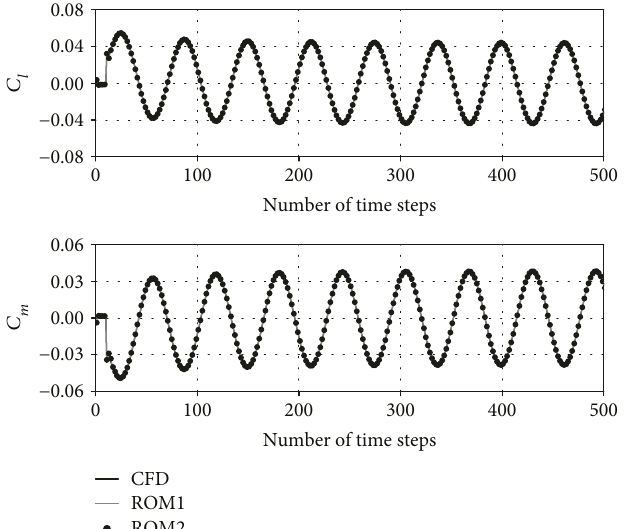
α = 0 deg (ROM1-training data via CFD; ROM2-training ∞ = 0 84 and 0